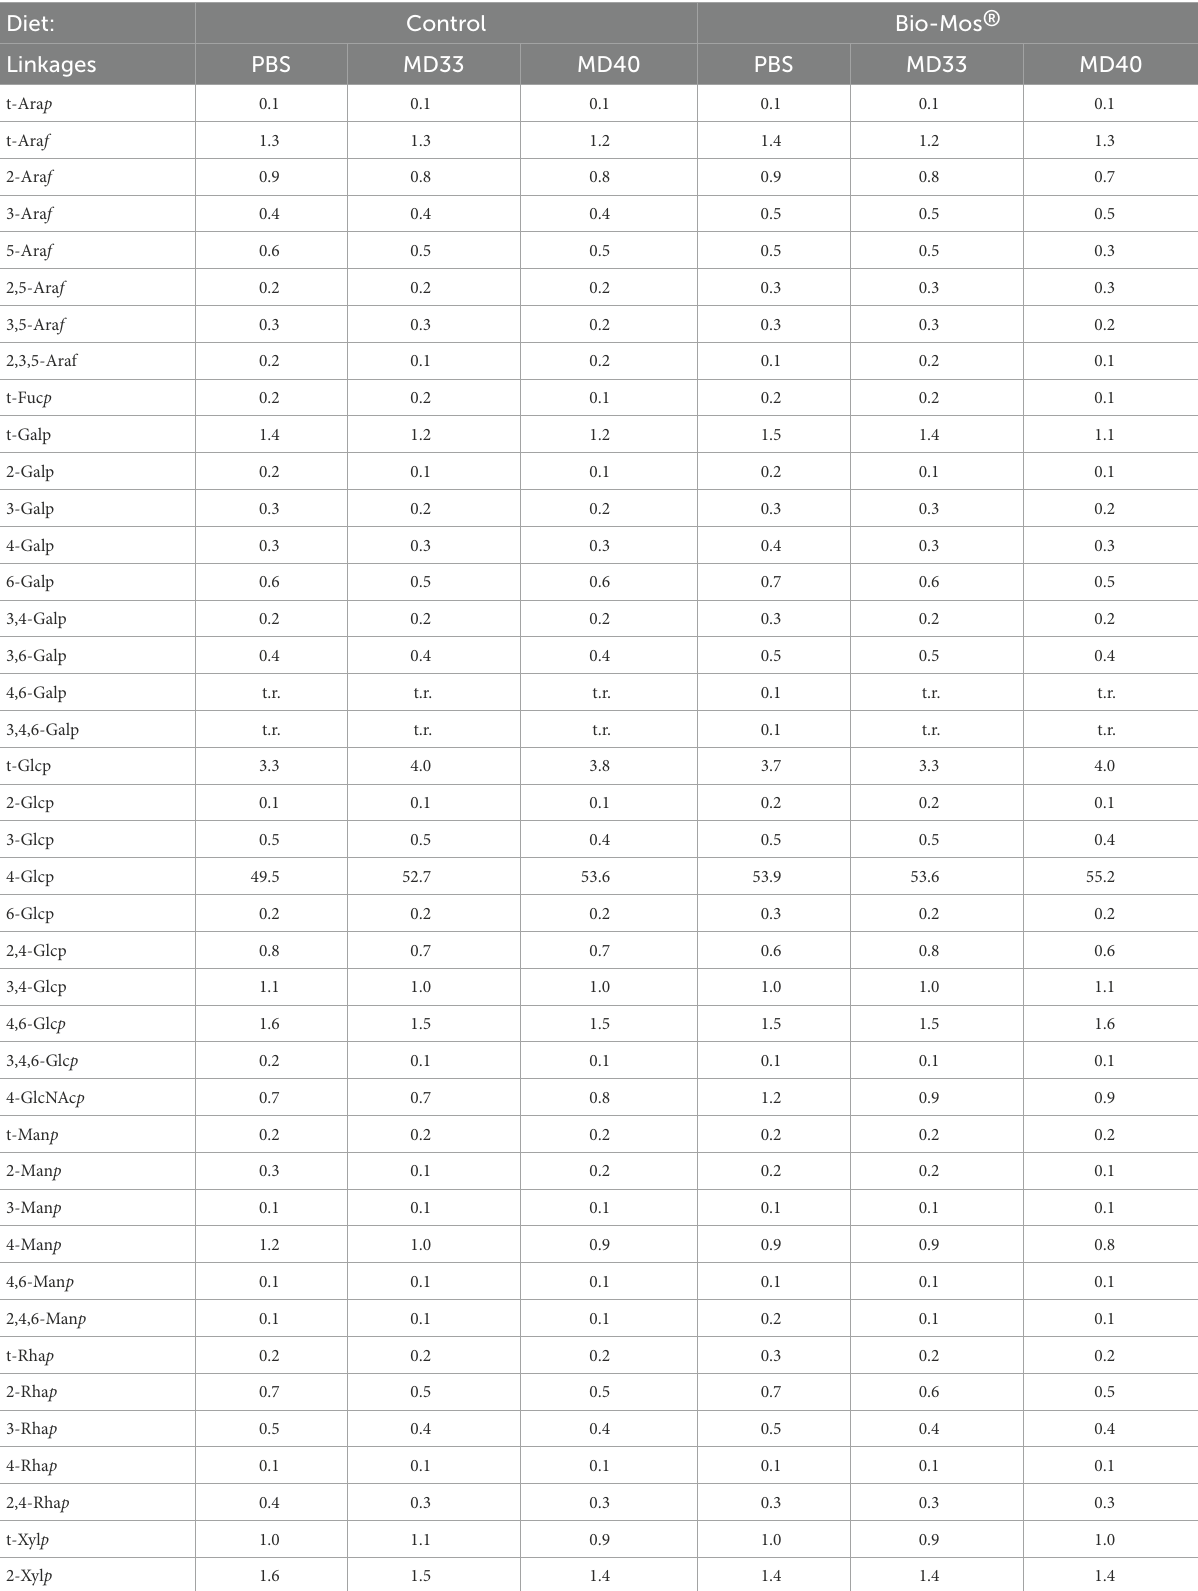
TABLE 2 Total cell wall linkage composition (%) of indigestible residues of rumen samples from cattle fed diets ± Bio-Mos®. Diet: Control